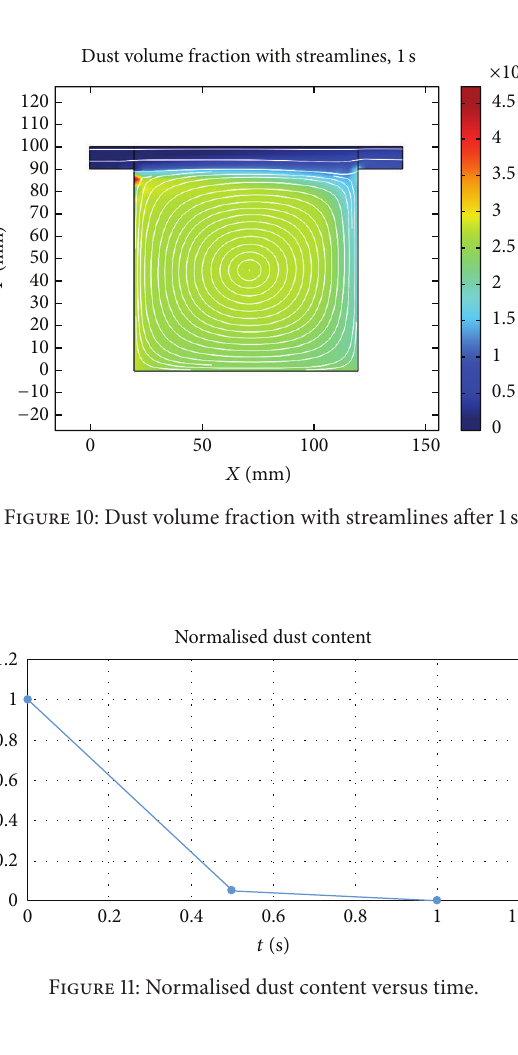
Figure 9: Dust volume fraction with streamlines after 0.5 s.